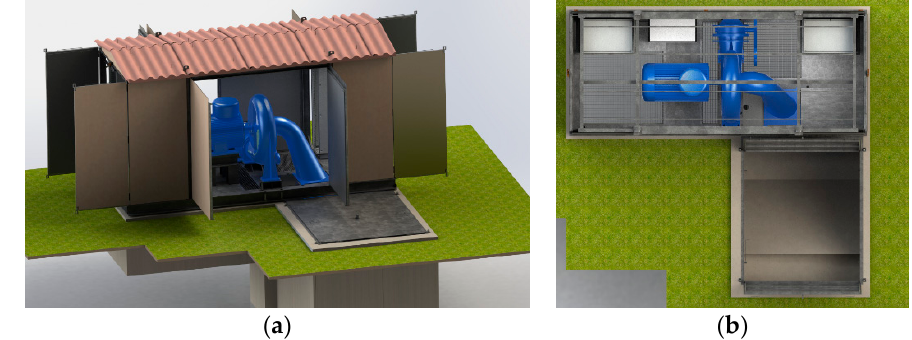
Figure 3. General Implantation.